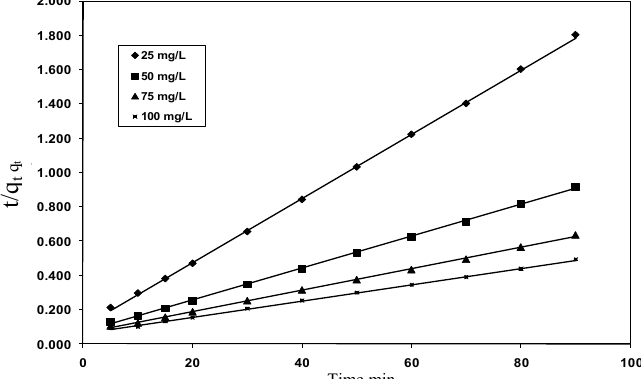
Figure 9. Pseudo second order plot for adsorption AG 25 onto ACC at 303